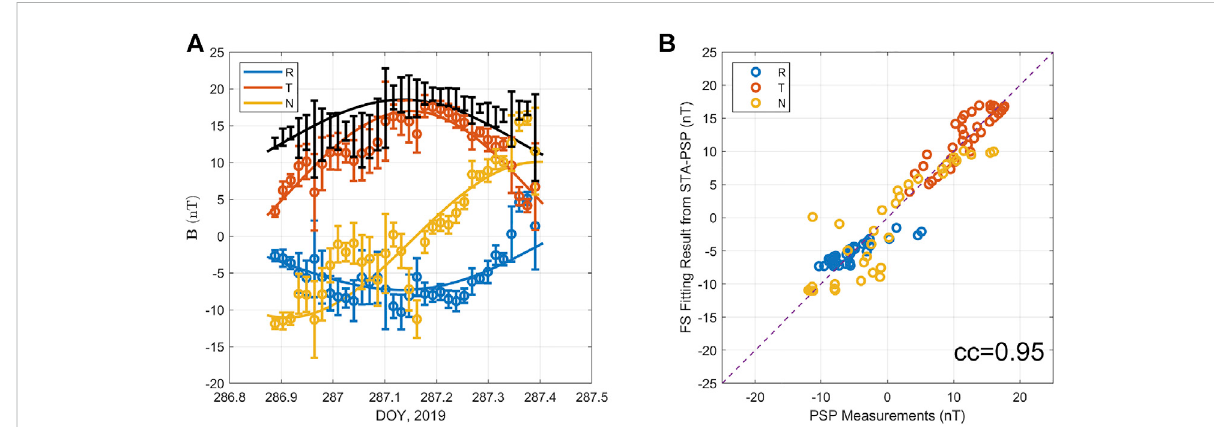
FIGURE 9 The comparison between the FS model output based on the optimal fi tting to the combined STA-PSP dataset and the actual measurements along the PSP spacecraft path. Format is the same as Figure 7. (A) time series of the fi eld components, and (B) the correlation plot with the overall correlation coef fi cient $cc = 0.95$ denoted. The corresponding correlation coef fi cients for each magnetic fi eld component in theRTN coordinates are 0.87, 0.89, and 0.89, respectively, for this analysis result.